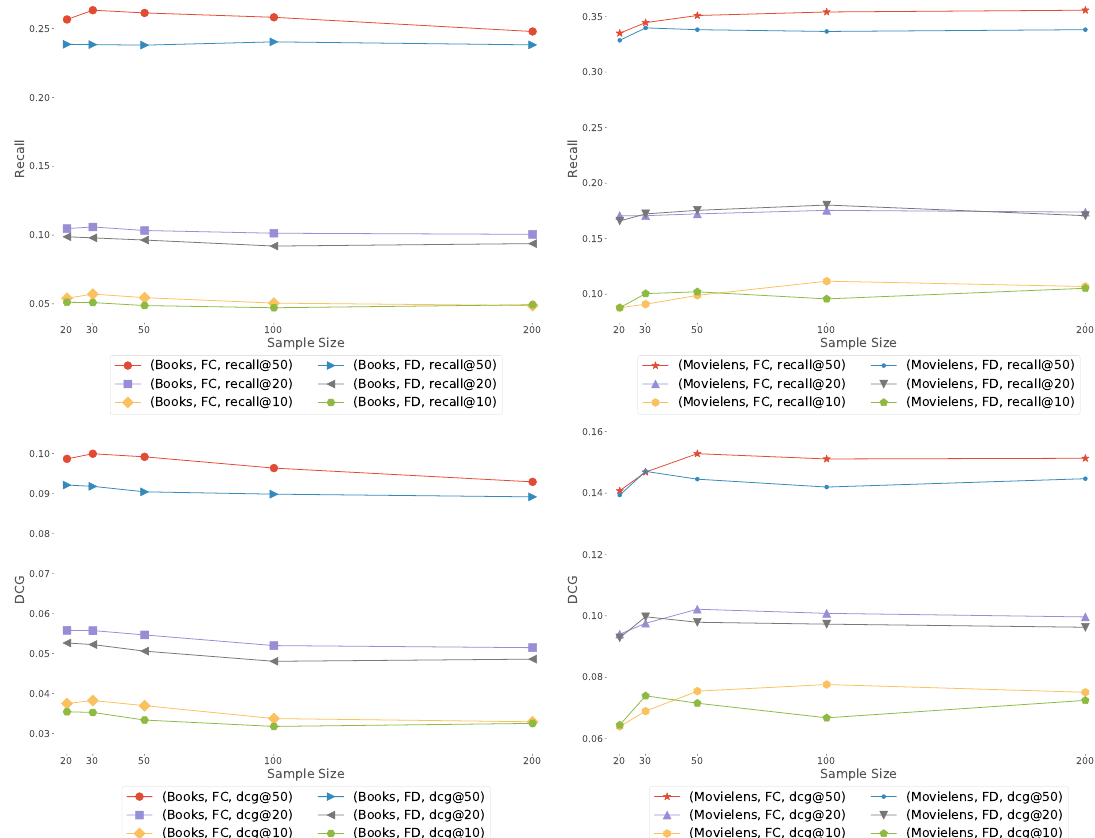
Figure 7. The quality of algorithms FD and FC with Jaccard similarity, as the function of the number of most popular items used as reference in the similarity graphs of Figures 1–3 (horizontal axis). The Recall ( top ) and DCG ( bottom ) increases as we add more items in the sample set (i.e., list of recommended items).